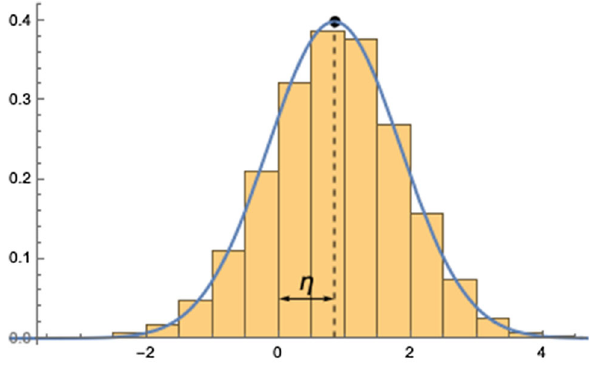
Fig. 2 Histogram showing the distribution of 10 4 replicas generated around an experimental value y 0 with unit variance. The central value y 0 , which is represented by the solid dot at the centre of the replica distribution, is drawn from a Gaussian distribution with unit variance centred at the true value f , which is assumed to be the origin in this plot. The central value y 0 is kept fixed for the whole set of replicas